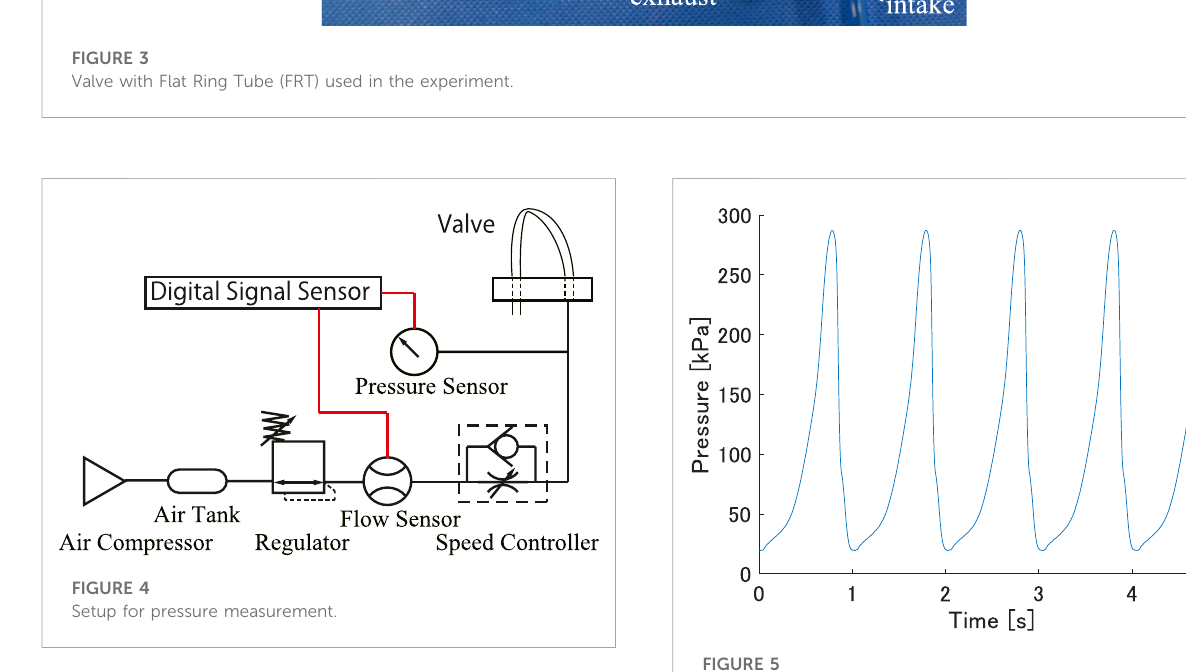
FIGURE 5 Typical waveform of the pressure measurement. The length, inter-axial width, and fl ow rate were 100 mm, 32 mm, and 15 L/ min,